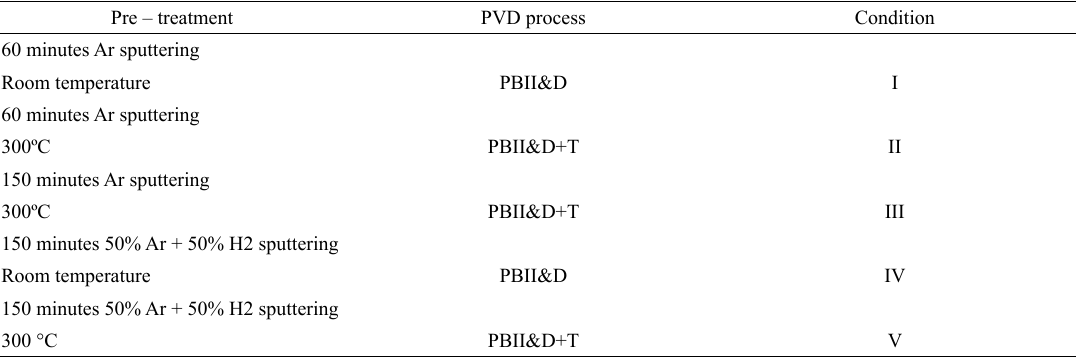
Table 2. Summary of the main parameters of the five studied conditions Pre – treatment